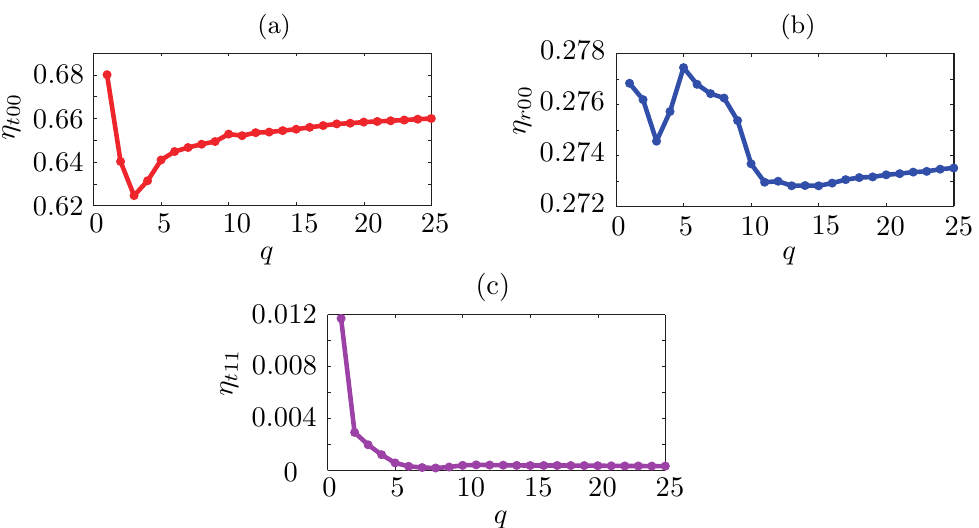
Figure A2. Diffraction efficiencies ( a ) η t 00 , ( b ) η r 00 , and ( c ) η t 11 plotted with respect to the number of Fourier coefficients used in the FMM calculations. The test object is a monolayer mesoporous silicon on a silicon